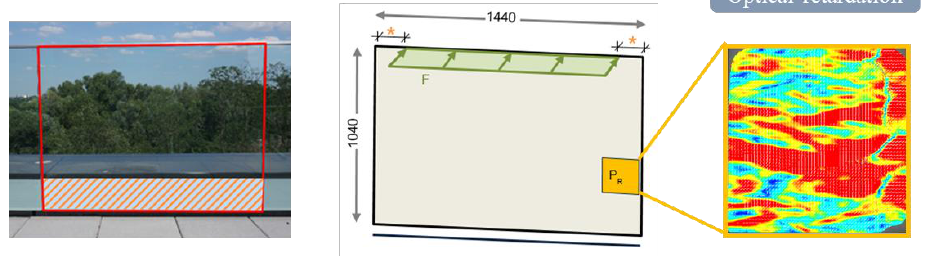
Fig. 11 Analysis of a glass balustrade, consisting of laminated thermal toughened glass (glued joint), with line load -> optical retardation (insufficient conclusion on constraints of glass caused by external loading).